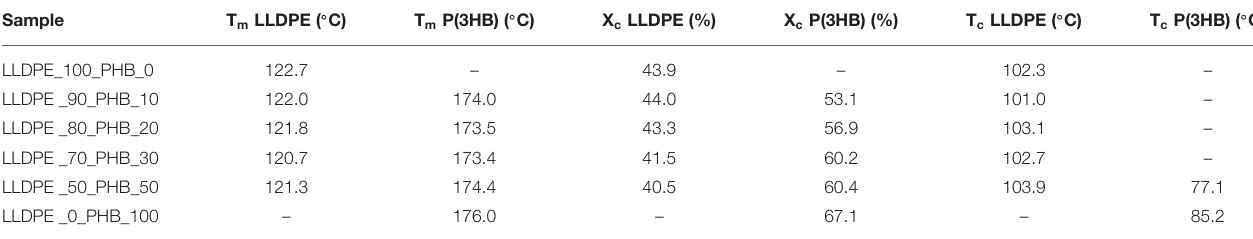
TABLE 1 | Results of DSC tests neat LLDPE and relative LLDPE/P(3HB) blends (first heating scan).